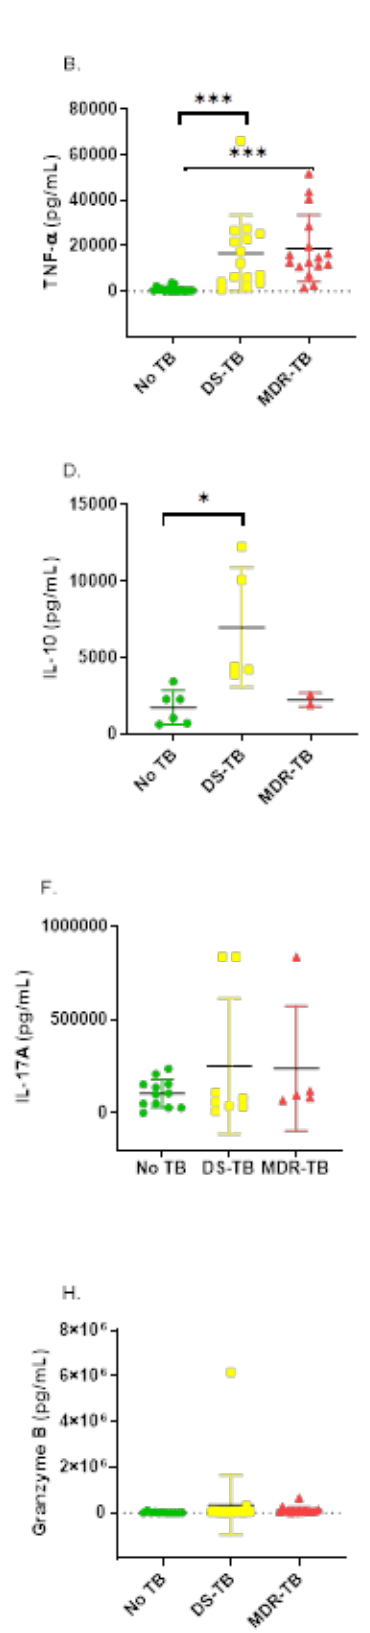
Figure 1. Background corrected serum concentrations of cytokines ( A – H ) in participants with MDR-TB (triangle), DS-TB (square), and No-TB (circle). Statistical differences were analyzed using Mann − Whitney U tests (* = p < 0.01, ** = p < 0.001, *** = p < 0.0001).